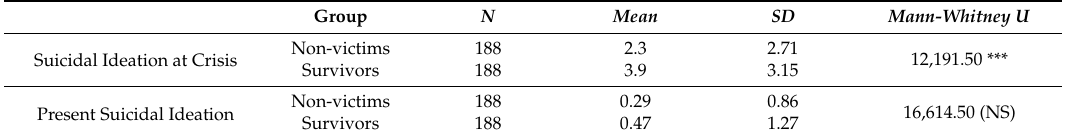
Table 1. Di ff erences in suicidal ideation at crisis and at present among CSA survivors and non-victims ( n = 376).